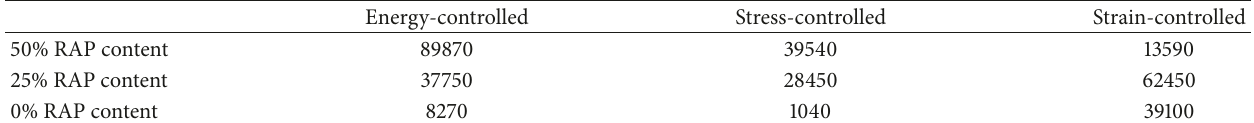
Table 4: Comparison of fatigue life under different control modes.